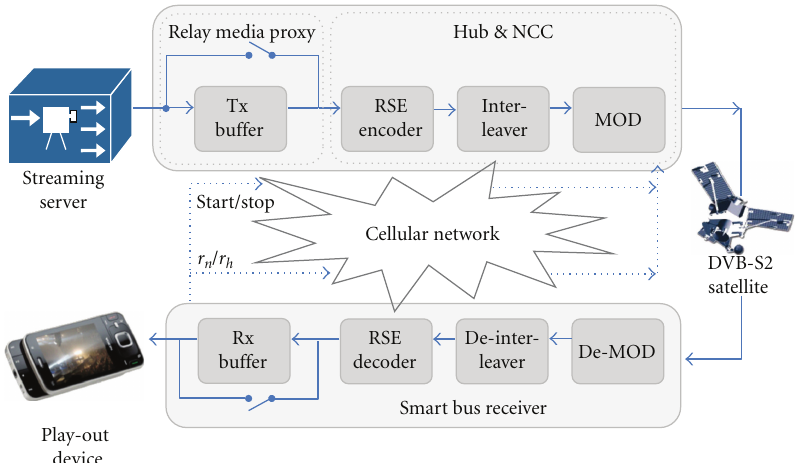
Figure 4: Tx/Rx chain for DVB communication to a vehicular